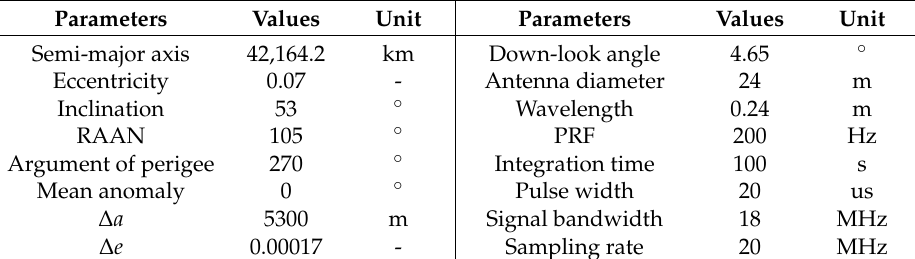
Table 8. Simulation parameters of the imaging validation experiment. Table 8 . Simulation parameters of the imaging validation experiment.